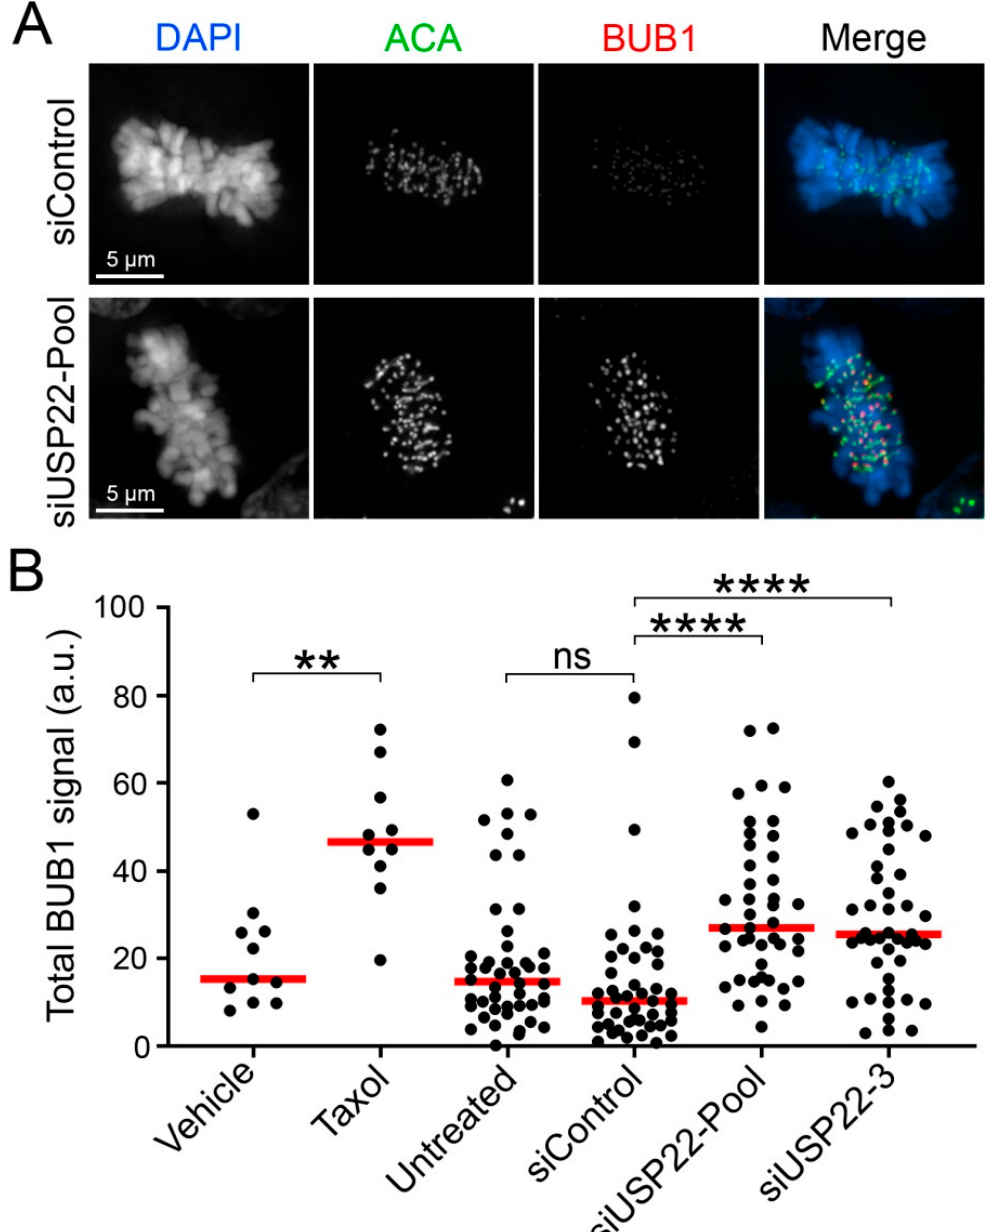
Figure 3. USP22 silencing increases BUB1 recruitment to kinetochores in metaphase cells. ( A ) Representative deconvolved 3D images (maximal intensity projection) of metaphase HCT116 cells immunofluorescently labeled for ACA and BUB1 following USP22 silencing. For quantitative purposes, all images were acquired using identical exposure times. Note the visual increase in BUB1 signal intensities within the USP22 -silenced condition (bottom panel) relative to siControl condition (top panel). ( B ) Dot plot showing the total kinetochore-associated BUB1 signal intensity/cell from a minimum of 40 metaphase cells per silencing condition (minimum 10 cells for vehicle control and Taxol conditions), with red bars identifying median intensities. Mann–Whitney tests identify significant increases in total BUB1 intensities (i.e., levels) following Taxol treatment (positive control) relative to vehicle control and following USP22 silencing relative to siControl (N = 2; n ≥ 10 for vehicle and Taxol controls; n > 40 for silencing conditions; ns p -value > 0.05; ** p -value < 0.01; **** p -value < 0.0001).